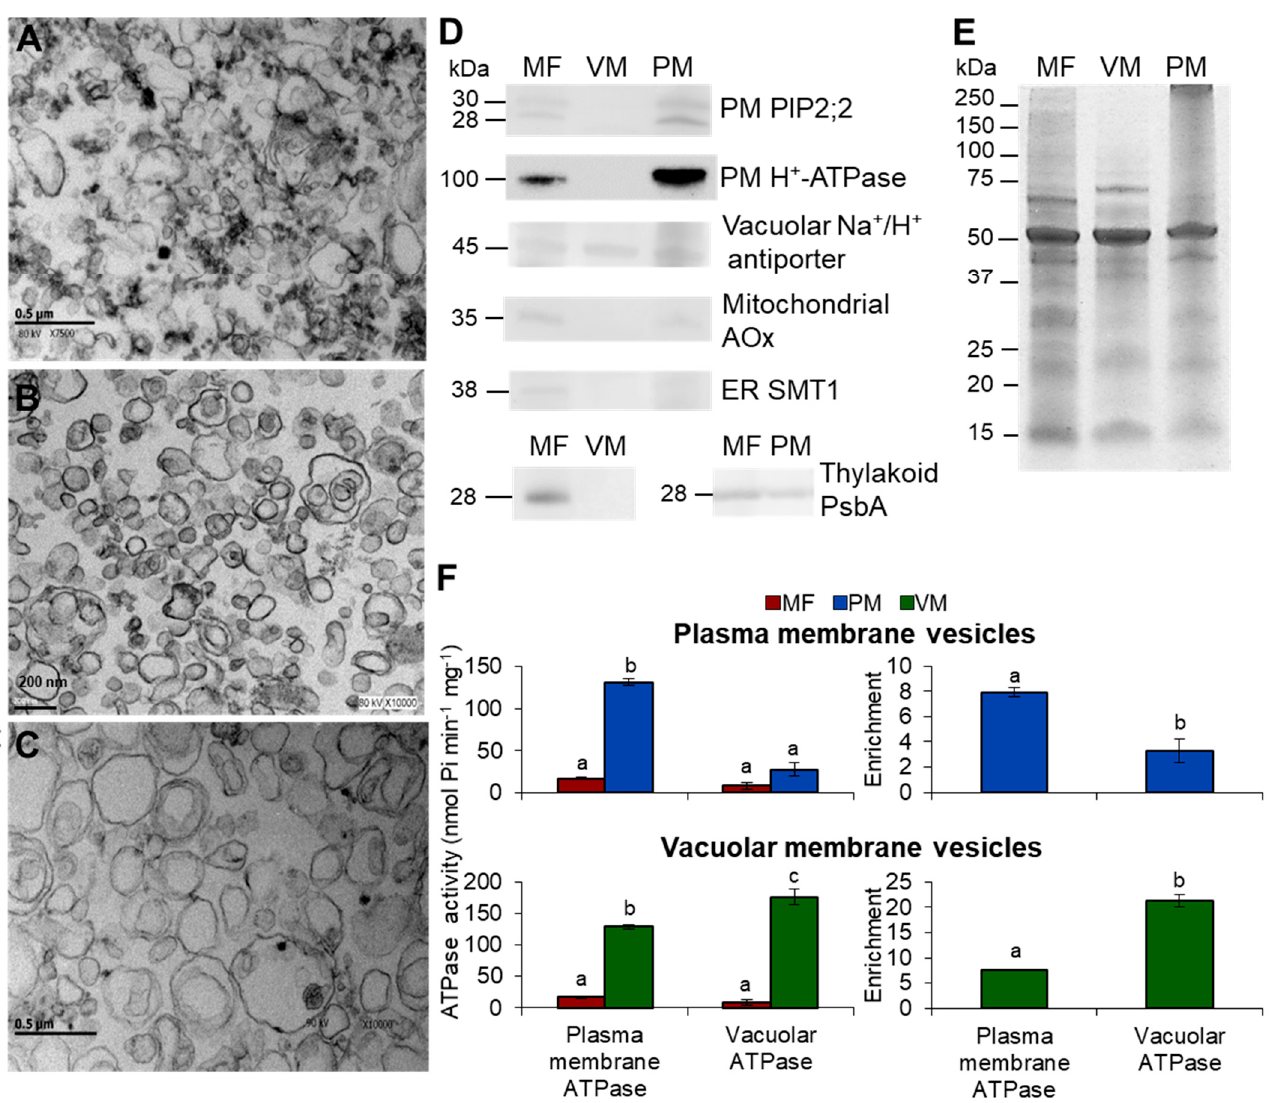
Figure 1. Purity assessment of isolated membranes from Arabidopsis thaliana leaves. Transmission electron micrographs from microsomal fraction (MF) isolated by differential centrifugation ( A ), plasma membrane (PM) purified by two-aqueous polymer partitioning system ( B ), and vacuolar membrane (VM) isolated by free flow zonal electrophoresis (FFZE) ( C ) from Arabidopsis thaliana leaves. ( D ) Immunodetection of membrane markers. MF, VM, and PM proteins were separated by SDS-PAGE and detected by immunoblot with specific antibodies as described under Materials and Methods. The H + -ATPase and the aquaporins PIP2;2 are the PM markers. The Na + /H + antiporter is the VM marker. The alternative oxidase AOx is the mitochondrial inner membrane marker. The sterol methyltransferase SMT1 is the ER marker. The PsbA protein is the thylakoid marker. ( E ) Replicate gel from the immunoblotted proteins stained with Coomassie blue. ( F ) Determination of ATP hydrolysis from PM H + -ATPase and VM H + -ATPase in the PM and VM vesicles. ATPase activity was measured as Pi release from ATP as described under Materials and Methods. Ultrastructure analysis consisted of 3 replicates from three preparations independently obtained. Western blots experiments were performed using 2 to 5 independent membrane preparations with 2 to 6 technical replicates. ATP hydrolysis assays included 5 independent MF preparations and 5 replicates, 3 independent VM preparations and 3 replicates, 6 independent PM preparations, and 15 replicates. Values are expressed as means ± s.e. from 6 to 15 replicates. The different letters a, b, and c indicate statistically significant difference at p < 0.05 (ANOVA